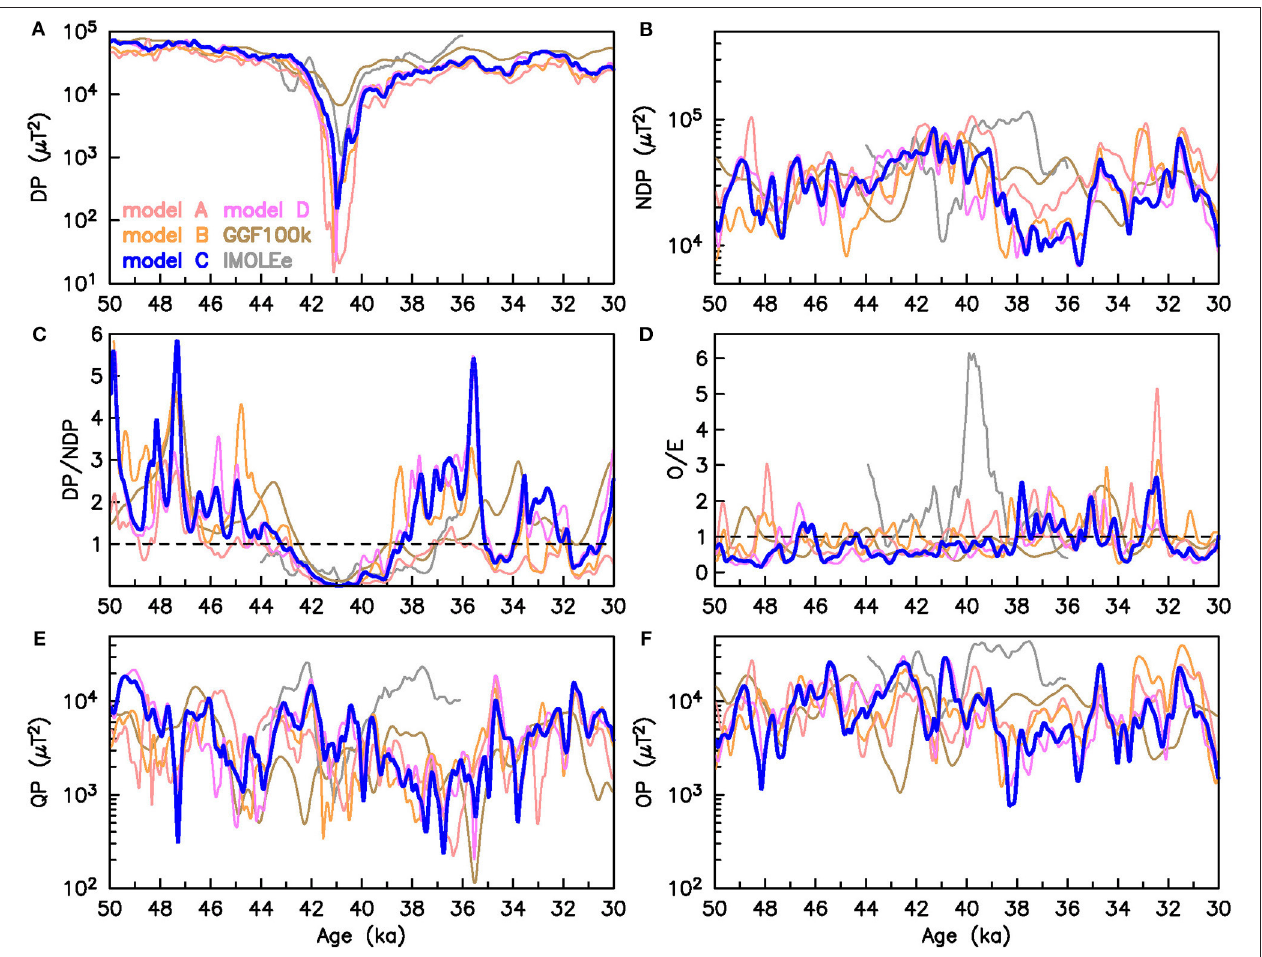
FIGURE 5 | Comparison of various measures of geomagnetic field behavior at the CMB for the six models. (A) Dipole power (DP), (B) Non-dipole power (NDP), relations of (C) power in dipole to non-dipole terms and (D) in odd (O) to even (E) SH terms, respectively, (E) Quadrupole power (QP), and (F) Octupole power (OP). Model C (LSMOD.2) is our preferred